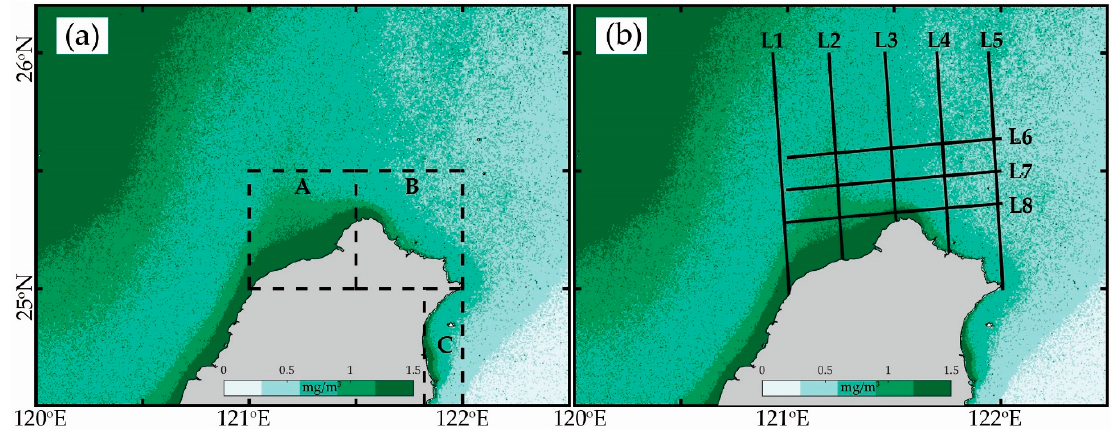
Figure 11. Long-term chlorophyll concentration map from April 2011 to May 2020 and observation area: ( a ) A (121–121.5° E; 25–25.5° N), B (121.5–122° E; 25–25.5° N, and C (coast; 122° E, 24.5–25° N), ( b ) L1 to L8 section line.